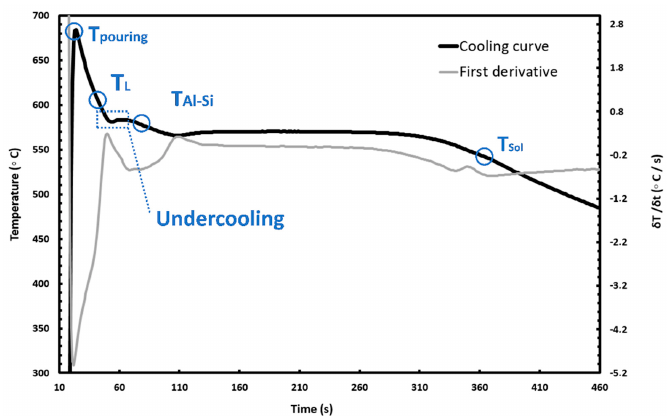
Figure 8. The cooling curve and the first derivative dT/dt of AlSi10MnMg alloy.